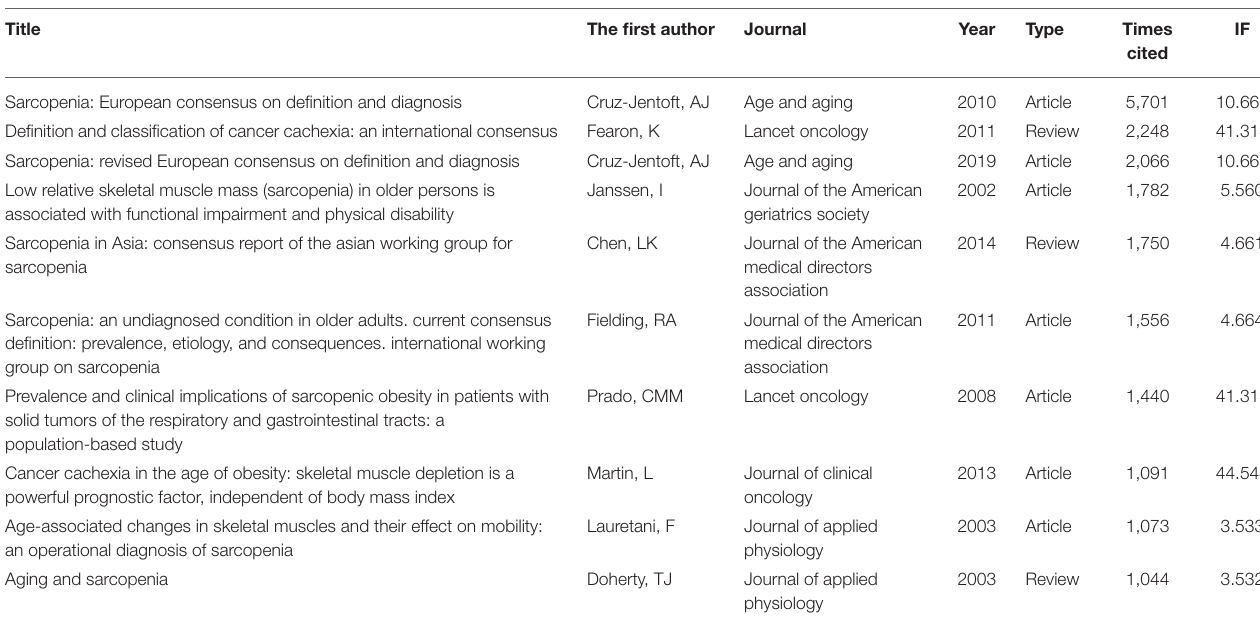
TABLE 4 | The Top 10 most frequently cited articles on sarcopenia in the